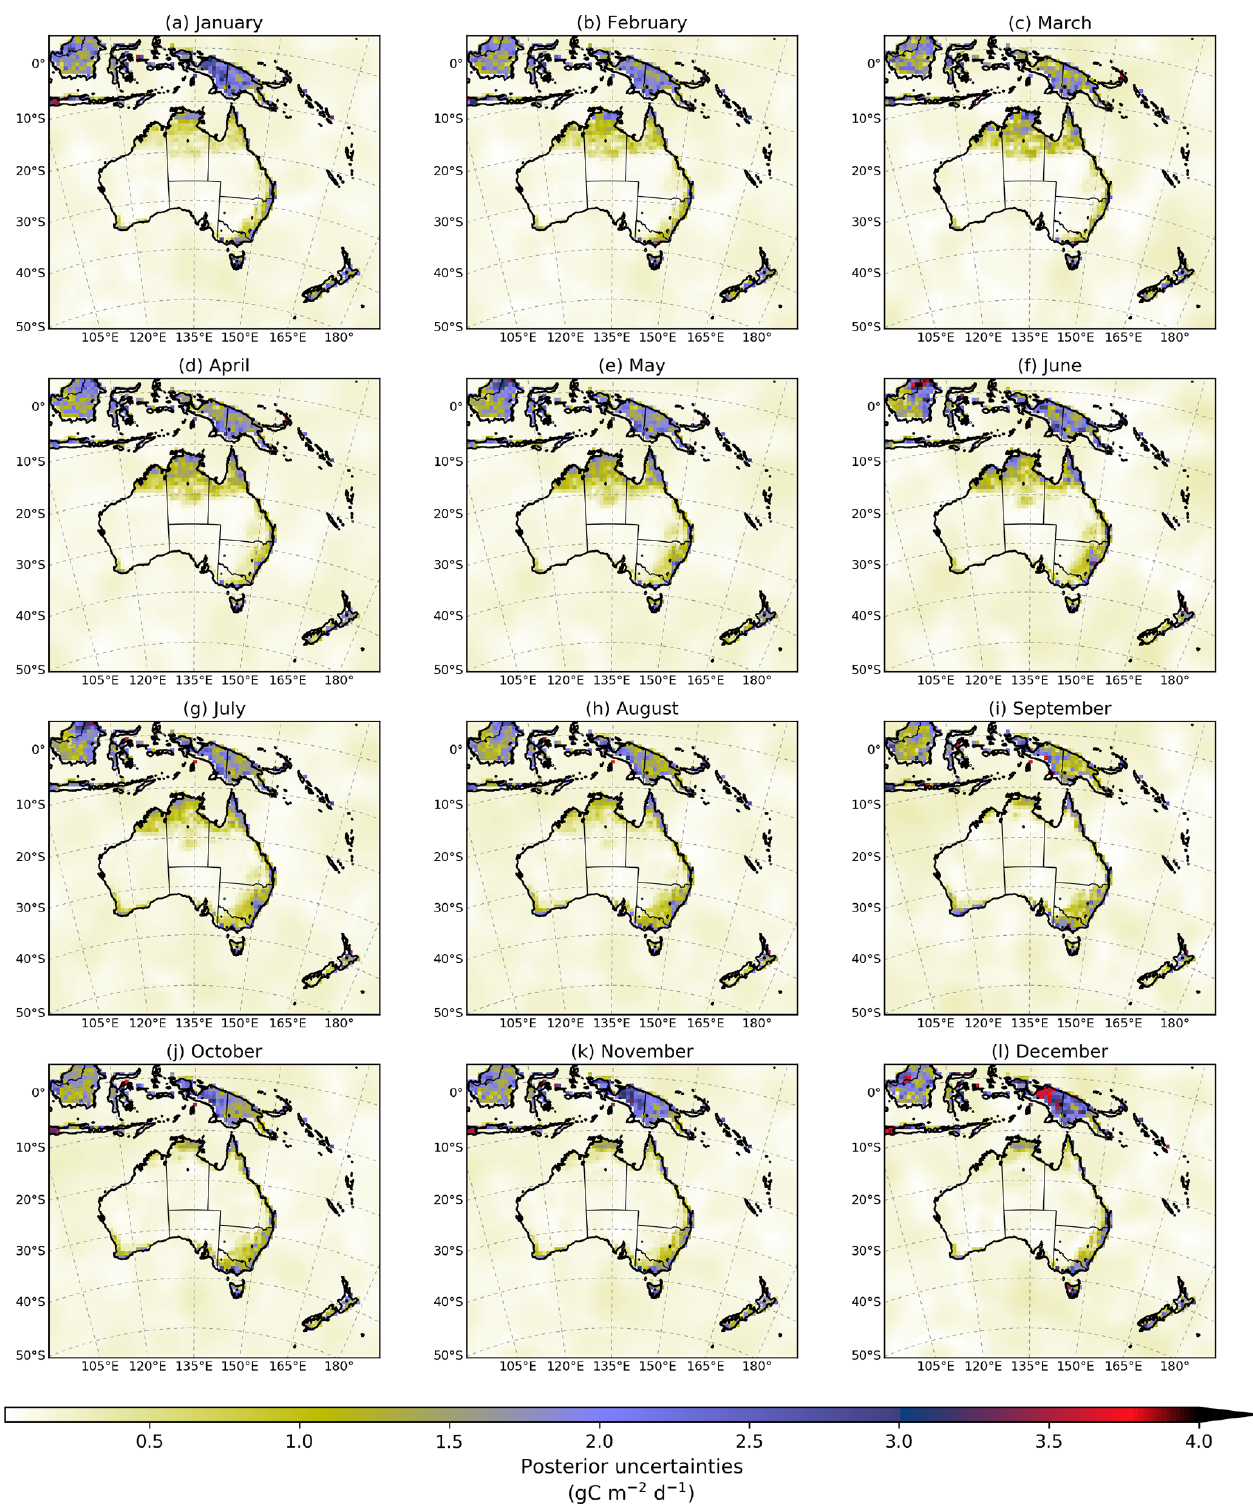
Figure D2. Posterior uncertainties calculated by OSSEs in Villalobos et al.